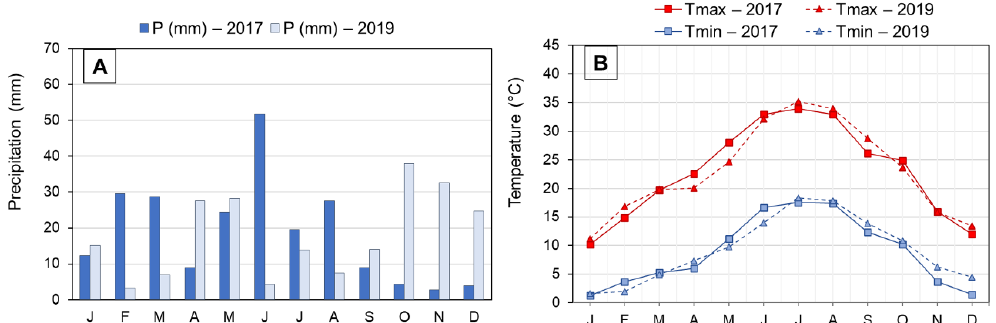
Figure 1. Monthly precipitation ( A ) and monthly air temperatures (maximum and minimum) ( B ) registered in Alcañiz (Teruel) during 2017 and 2019 crop seasons. Abbreviations: P, precipitations; Tmax, average maximum temperatures; Tmin, average minimum temperatures. J, January; F, Feb ‐ ruary; M, March; A, April; M, May; J, June; J, July; A, August; S, September; O, October; N, Novem ‐ ber; D, December.